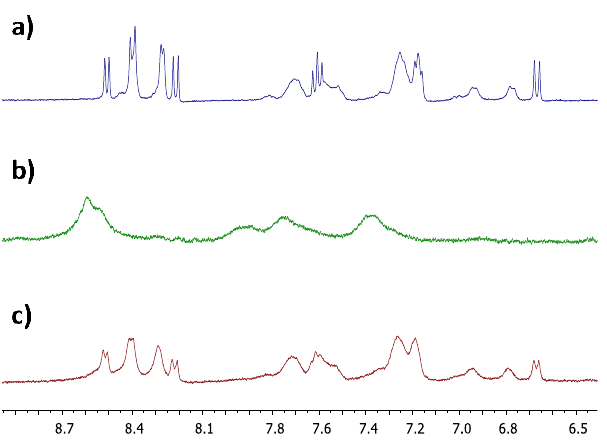
Figure 4. Aromatic region of the 1 H NMR spectra of 4 ( a ), with subsequent addition of two equiv. of Cu 2+ ( b ) and two equiv. of EDTA ( c ) (see figure S4 for full spectra). [ 4 ] = 2.2 mM; D 2 O:CD 3 OD 50:50; T = 298 K.